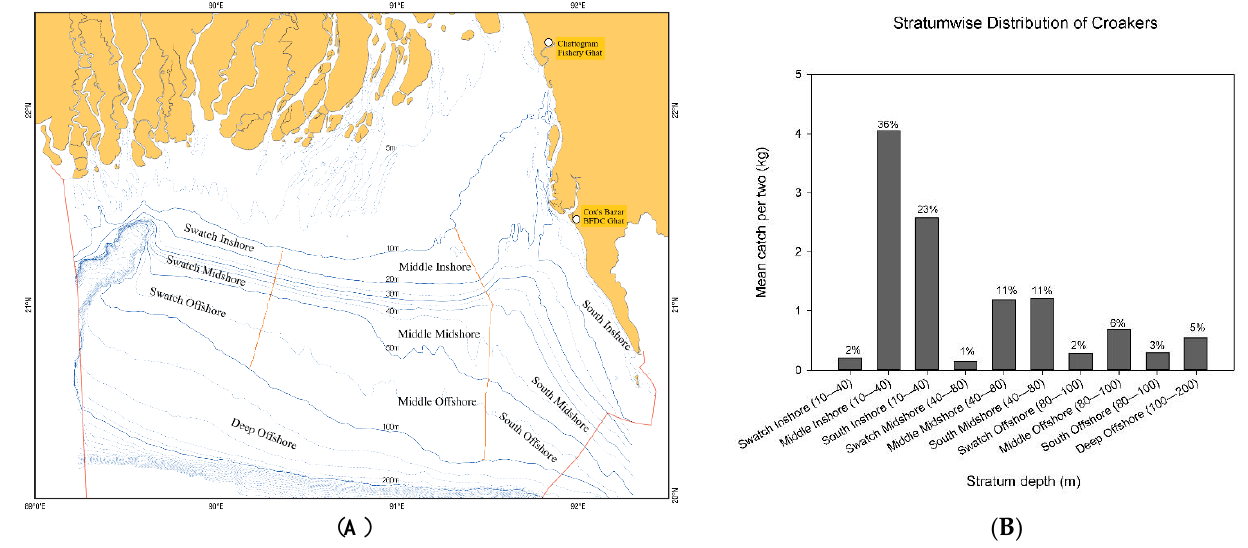
Figure 1. ( A ) . Bay of Bengal, Bangladesh coastal map showing the different stratum. ( B ). Stratum wise distribution (%) of Croakers.